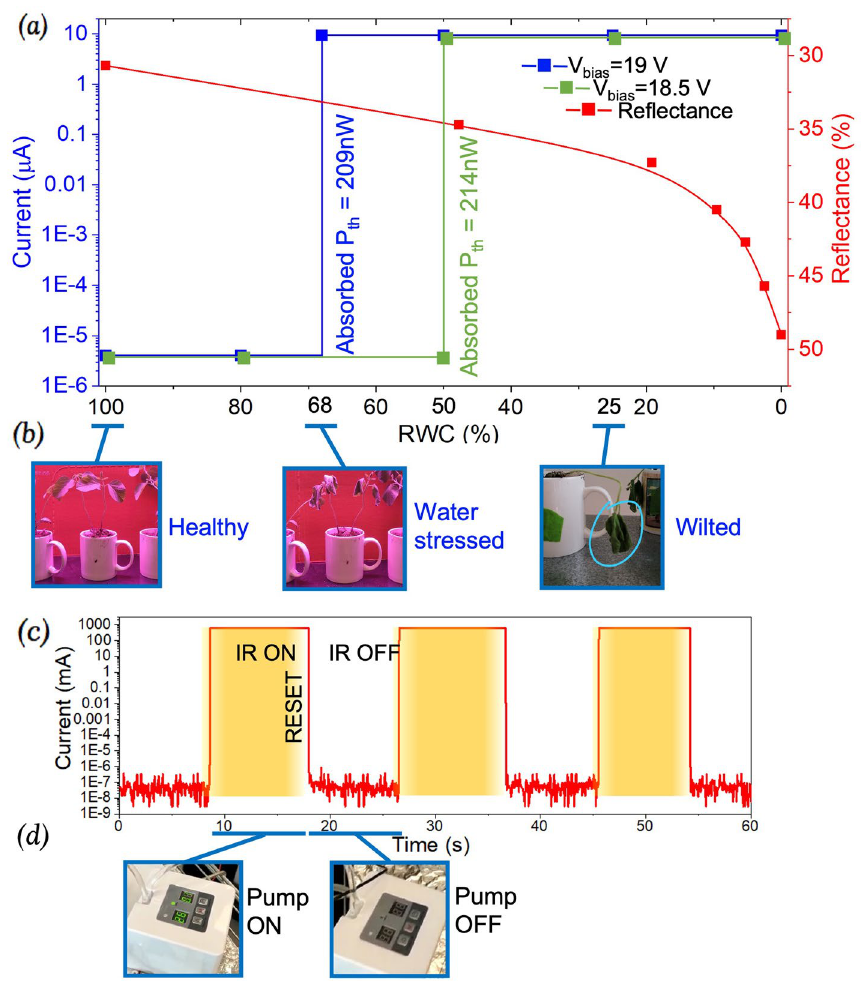
Figure 4. ( a ) Experimental result of the current flowing through the PMP with two different bias voltages and reflectance of the leaf as a function of the relative water content (RWC) of the leaf. ( b ) The tested soybean plant at different RWCs (100%, 68%, and 25%). ( c ) Measured current through the entire system in response to chopped IR radiation reflected off the leaf at RWC = 68%. The PMP latches ON after each detection and the reset function returns the switch to an OFF state until triggered ON again by above-threshold IR. ( d ) The water pump turns ON when the PMP closes as a response to IR radiation reflected off the leaf at RWC = 68%. After the reset, the water pump remains OFF until triggered ON again by an above-threshold IR